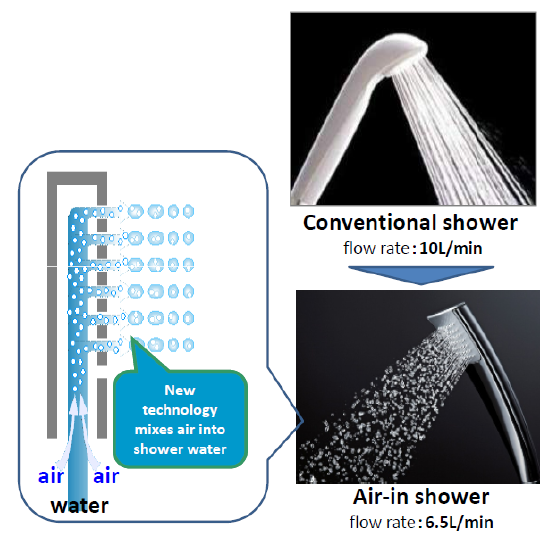
Figure 7. Outline of water-saving shower in Japan.